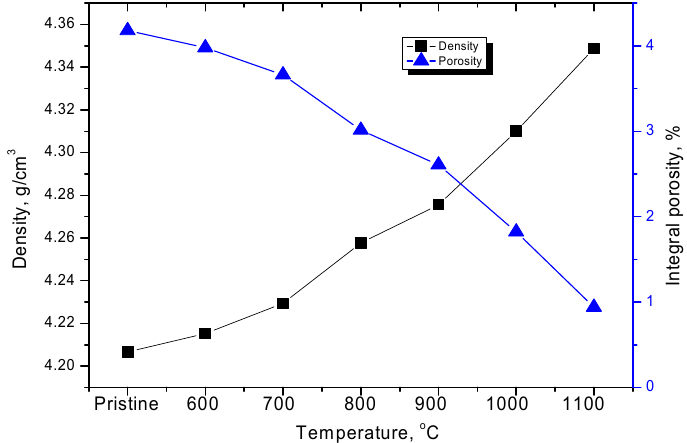
Figure 4. Dynamics of changes in density and porosity of ceramics versus annealing temperature.